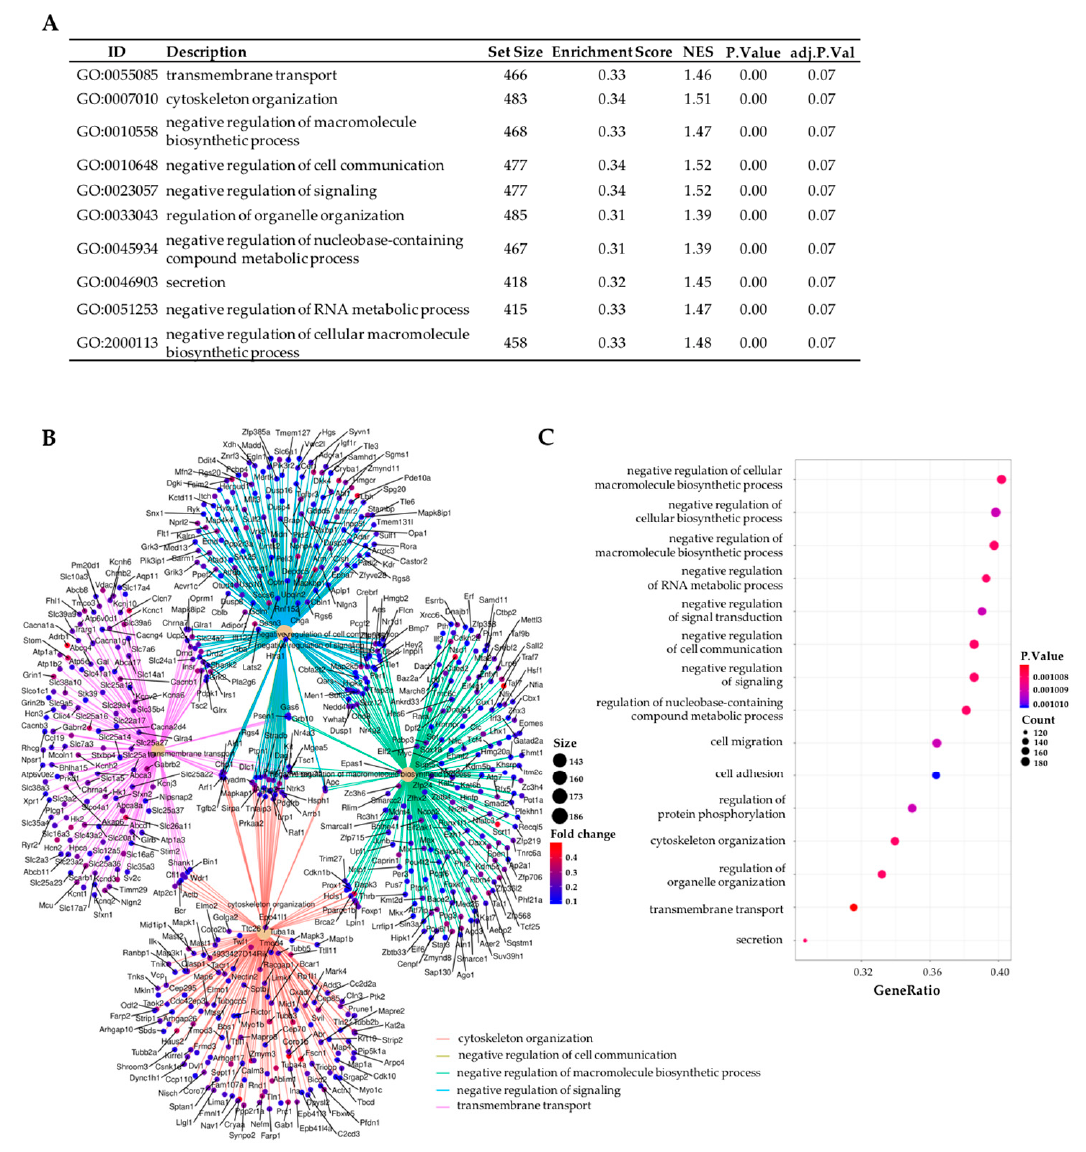
Figure 3. Enrichment analysis of the transcriptome study between vehicle-treated db/db mice and db/db mice treated with sitagliptin using the GO Database (BP subcategory). ( A ) Table of top 10 enriched GO terms (BP) for the comparison “db/db sitagliptin vs. db/db vehicle”. ( B ) Network plot of the top five enriched GO term (BP) for “db/db sitagliptin vs. db/db vehicle”. ( C ) Dot plot of the top 15 enriched GO terms (BP) for the “db/db sitagliptin vs. db/db vehicle” comparison. Results were adjusted with a p -value less than 0.25 The results shown correspond to the top enriched terms with an adjusted p -value < 0.07.